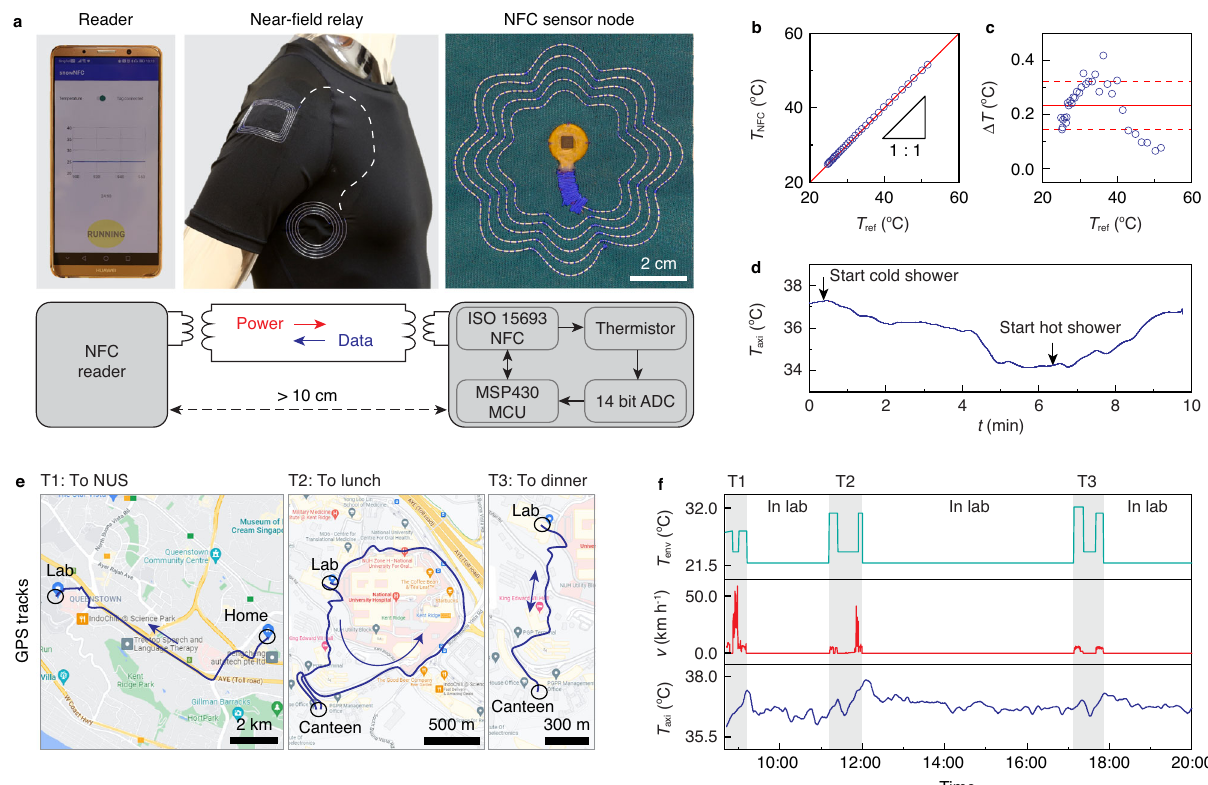
Fig. 5 Continuous axillary temperature monitoring. a Textile thermal monitoring system comprising a sensor node connected with a smartphone reader via a near- fi eld relay integrated on a shirt. The top row shows images of the system components while the bottom row shows the block diagram. The distance between the reader and sensor node is more than 10 cm apart. b and c Calibration of the measured temperature T NFC with a reference thermometer T ref . Δ T = T ref − T NFC is the temperature difference. The red solid line and dash lines in ( c ) show mean ± s.d. d Axillary temperature T axi measured in a shower. The cold shower used ~25 °C water while the hot shower used ~40 °C water. e Map of the GPS position of the subject. f Axillary temperature T axi streamed by the wireless system over a day. Velocity v of the subject and environment temperature T env obtained from the smartphone are plotted for reference. Source data are provided as a Source Data fi end-to-end resistance using a multimeter. Textile permeability tests were performed by sealing a glass bottle fi lled with 100-g water with the textile sample. The bottles were placed in a chamber with 37.5°C and 20% relative humidity. Water loss was calculated by measuring the remaining mass. Numerical simulation . Electromagnetic simulations used CST Microwave Stu- dio (Dassault Systems) using the frequency domain solver to compute the fi eld distributions at 13.56 MHz. The receiver was modeled using a copper planar inductor with dimensions of 10.4 mm × 11.9 mm, 0.127-mm track width, 0.254-mm gap and 5 turns. The distance between the transmitter and receiver was set at 1 cm unless otherwise stated. For the implantable con fi g- uration, tissue was modeled by a dielectric permittivity of 78.4 and conductivity of 0.93 S m − 1 . Wireless measurements . Wireless power experiments used acrylic cylindrical containers with radii of 2.5, 5, and 10 cm fi lled with 1× PBS. The transmitter was a rectangle spiral liquid metal antenna (37 mm× 52mm, 3-mm gap, and 4 turns) and the receiver the copper planar inductor previously used in numerical simu- lations. A blue LED was connected to the terminals of the receiver inductor for visualization. Both the transmitter and receiver were tuned to resonate at 13.56 MHz using matching networks. While the transmitter was driven by a signal generator with a continuous sinusoidal wave (input power of 20dBm at 13.56 MHz), the receiver was moved inside the cylinder, and the LED recorded by a camera (Canon 6D) using a 30-s exposure. On-body wireless power experiments used a transmitter fabricated by digital embroidery of a fabric-based skin patch. The patch is a commercially available disposable sticker (Wormwood sticker, Ai Yi Shi) that has an adhesive layer on one side. The result is an ergonomic patch with a 5 turn, 3-mm gap inductive pattern that can be conformally placed on various curved body surfaces. The receiver used the same copper antenna described in previous paragraph, which was matched to resonant at 13.56 MHz, and was either directly attached to the skin under the patch or placed under a 1-cm-thick human tissue phantom (1% Agarose gel in 1× PBS)